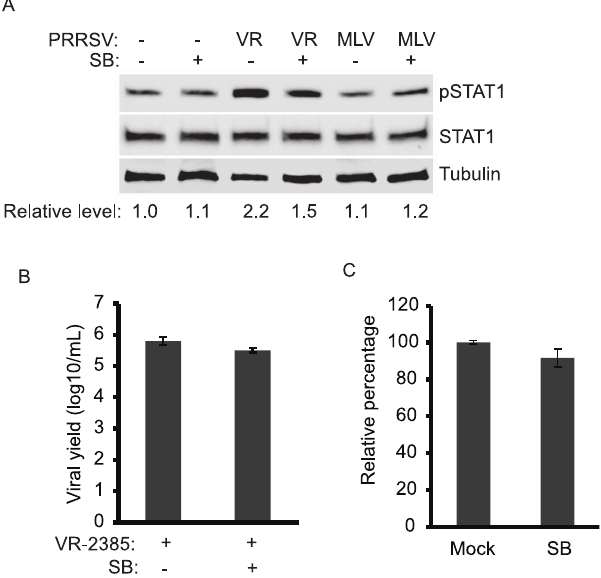
Figure 3. The p38 MARK signaling pathway is involved in pSTAT1-S727 elevation in PRRSV-infected cells. A. SB203580 treatment leads to inhibition of PRRSV-induced pSTAT1 elevation. MARC-145 cells were infected with PRRSV and treated with SB203580. At 24 hpi, the cells were harvested for Western blotting with antibodies against pSTAT1-S727, STAT1, and tubulin. B. PRRSV yield remains unchanged in the presence of SB203580. Cell culture supernatant samples of PRRSV-infected MARC-145 cells in the presence or absence of SB203580 were titrated. The viral yield is shown as log10 TCID50/ml. C. Cell viability assay of SB203580-treated MARC-145 cells. The cells were subjected for the assay 24 h after treatment. Relative percentages in comparison with mock-treated cells are shown.